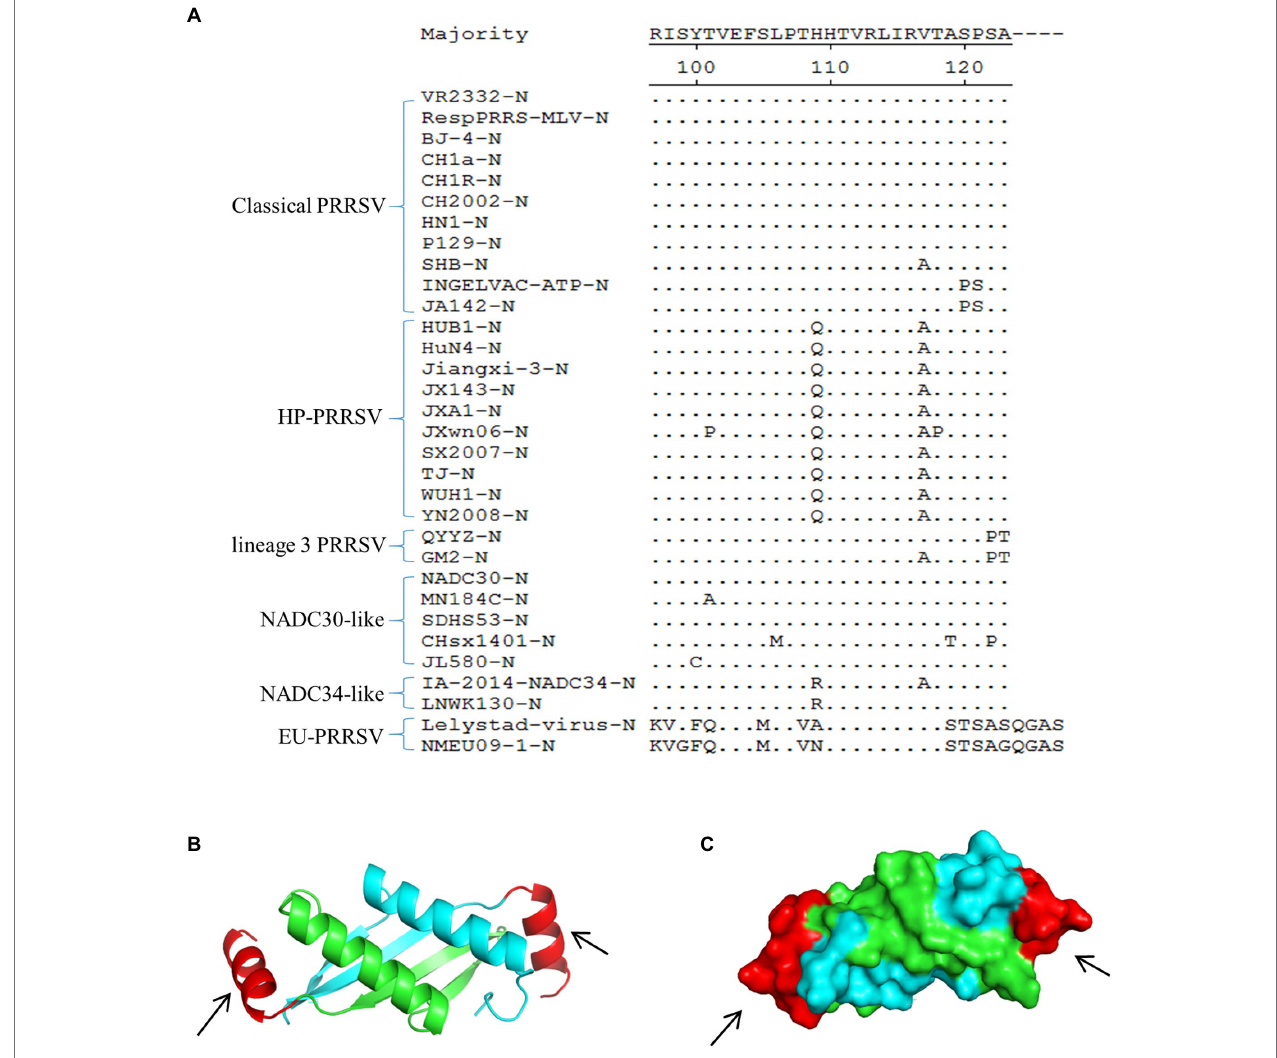
FIGURE 3 | Multiple sequence alignment and spatial localization of the N protein epitope recognized by mAb 1H4. (A) Multiple sequence alignment result. The evaluated strains include classical PRRSV, HP-PRRSV, lineage 3 PRRSV, NADC30-like strains, NADC34-like strains, and EU-PRRSV. The epitope on the N protein is highly conserved among the HP-PRRSV strains and classical PRRSV, whereas several substitutions are present in the other PRRSVs. The amino acid sequences were aligned using DNASTAR MegAlign software. (B) 3D structure of the SDHS53-N protein (aa 68 ~ 118) predicted using the SWISS-MODEL online server. Different colors represent each monomer of the homodimer N protein, and the mAb 1H4 epitope (aa 107 ~ 123) is highlighted in red (aa 107 ~ 118). (C) The relative localizations of the identified mAb 1H4 epitope on the predicted 3D structure of SDHS53-N protein are highlighted in red by PyMOL software (the location marked by the black